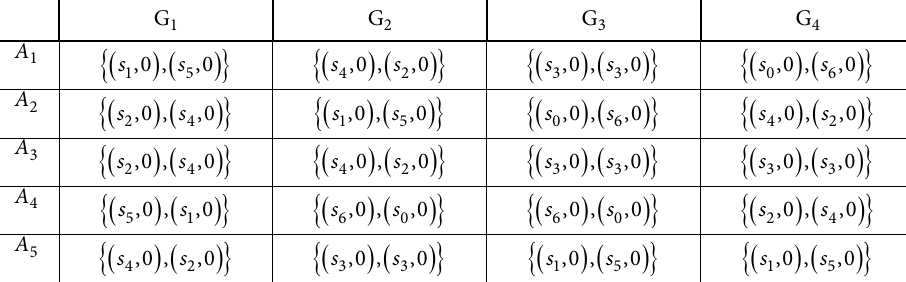
Table 5. The assessing matrix with 2TLPFNs by first expert